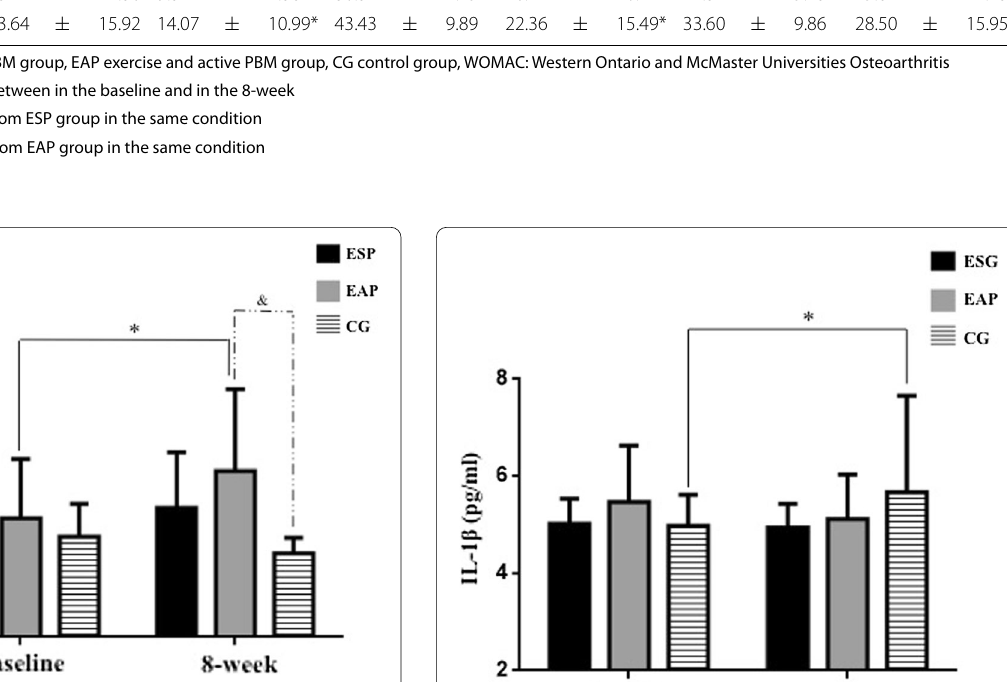
Fig. 3 Values of IL-10 concentration in the baseline and in the 8-week for all the experimental groups. IL-10: interleukin-10; ESP: exercise and sham PBM group; EAP: exercise and active PBM group; CG: control group. * statistical significance between in the baseline and 8-week values. & statistical significance between in the 8-week values